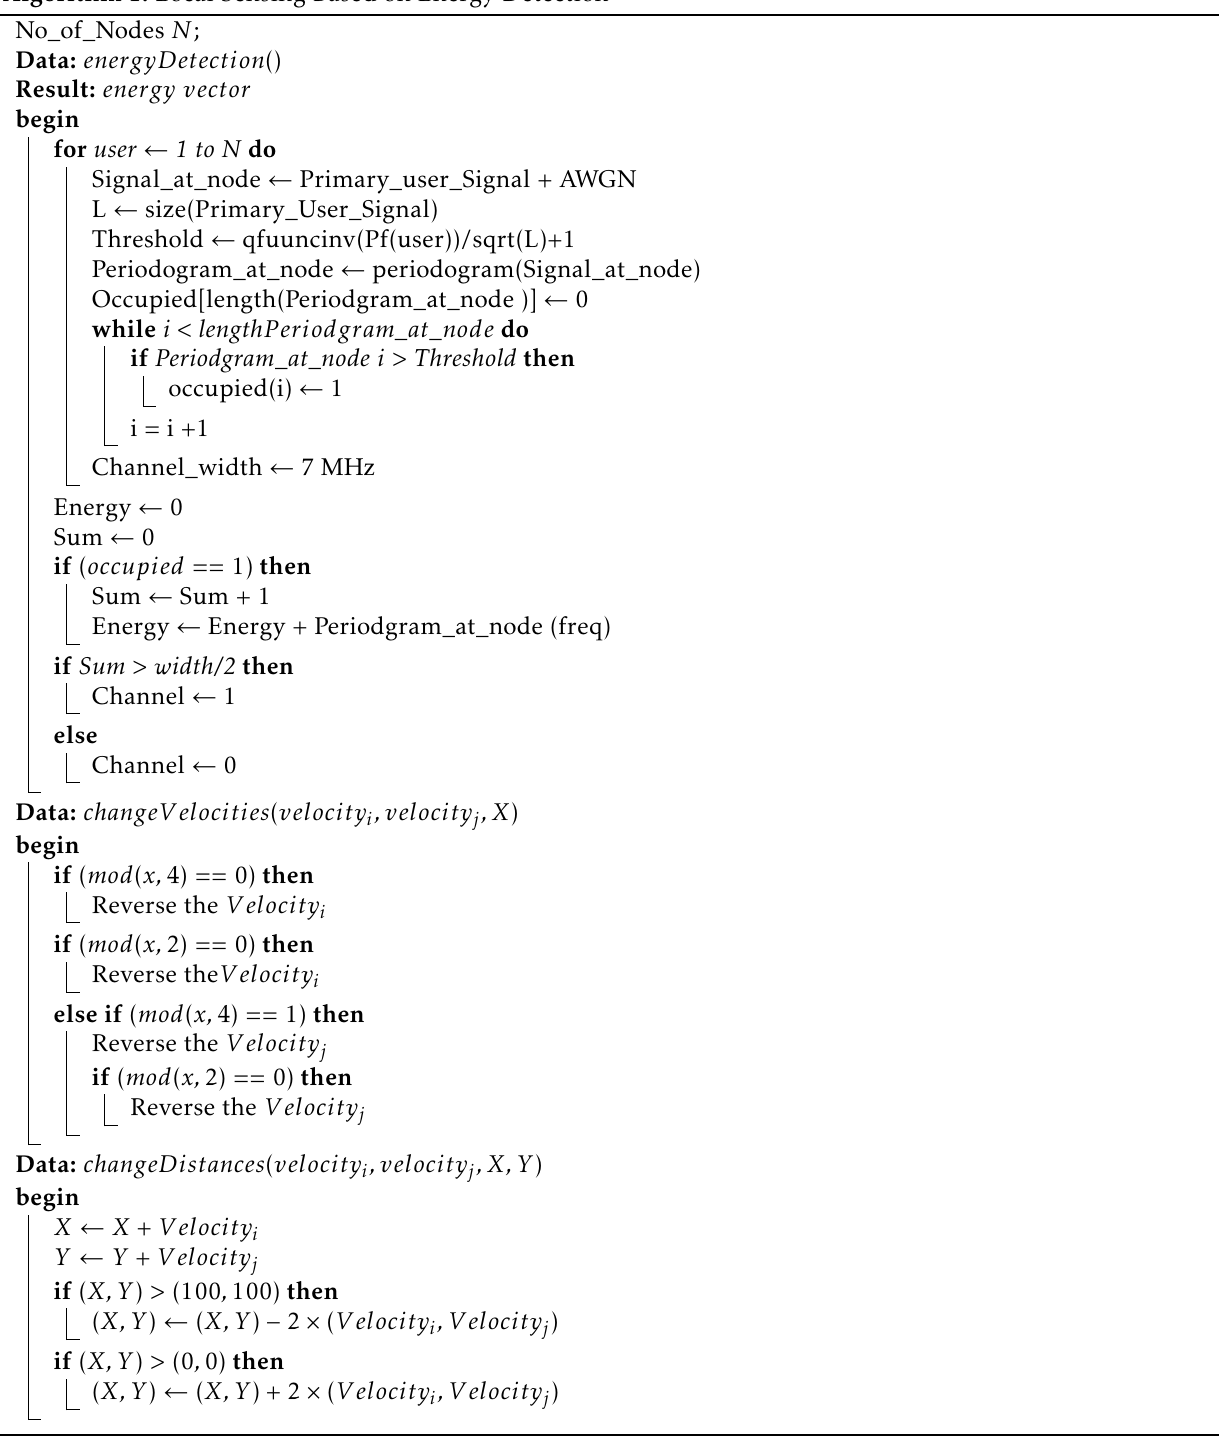
Algorithm 1: Local Sensing Based on Energy